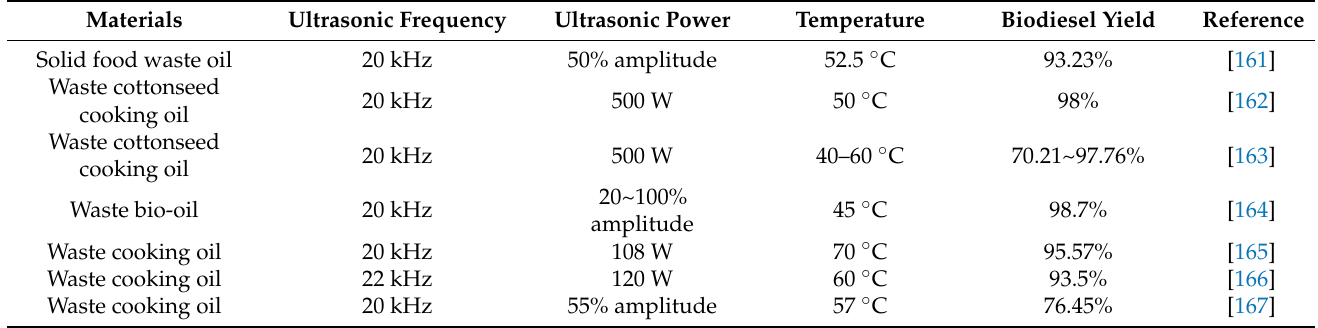
Table 3. Ultrasound-assisted transesterification of food waste to produce biodiesel.